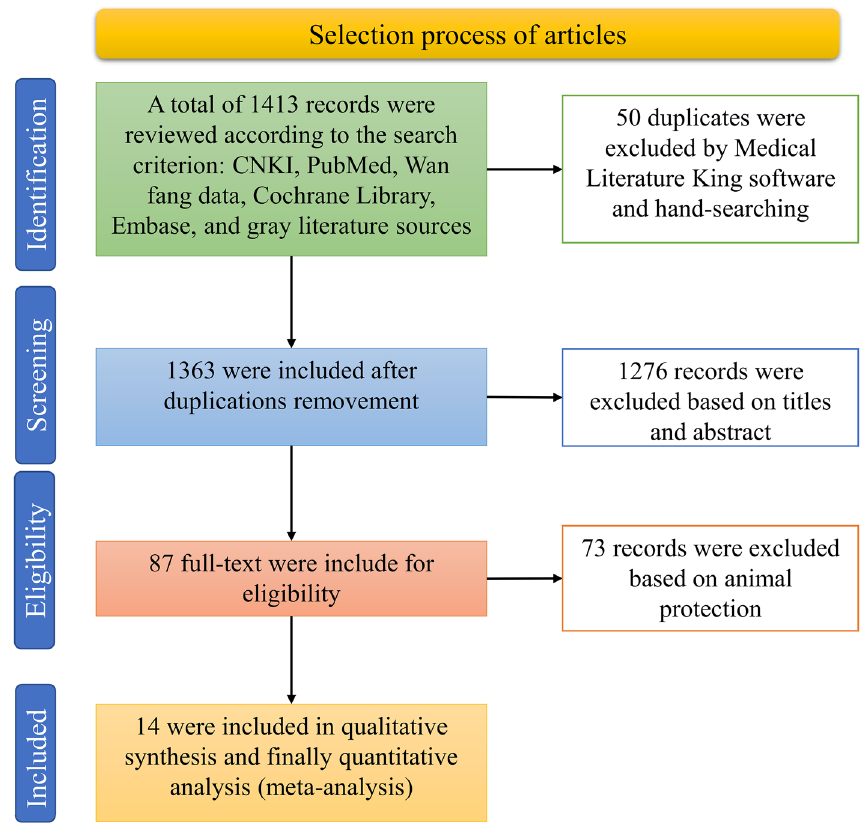
Figure 1. PRISMA flow diagram of search